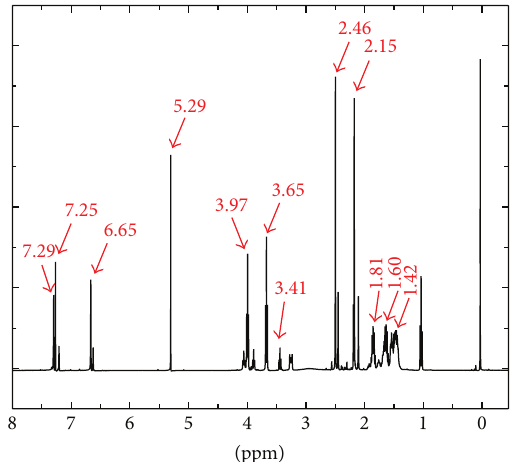
Figure 9: 13 C NMR spectrum of 4-[(6-bromohexyl)oxy]-2,5-